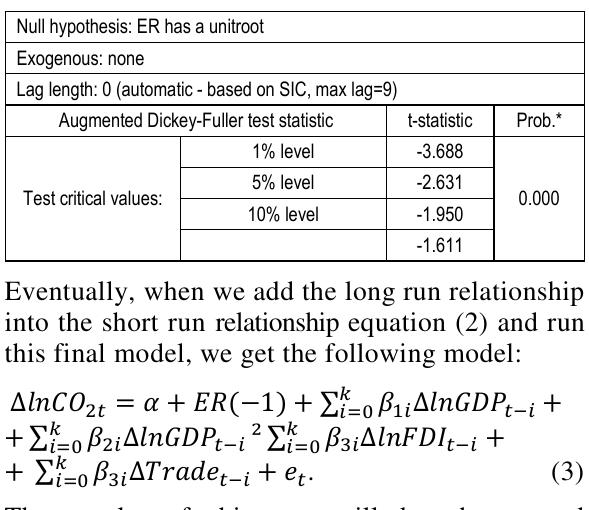
Table 3. Cointegration test results